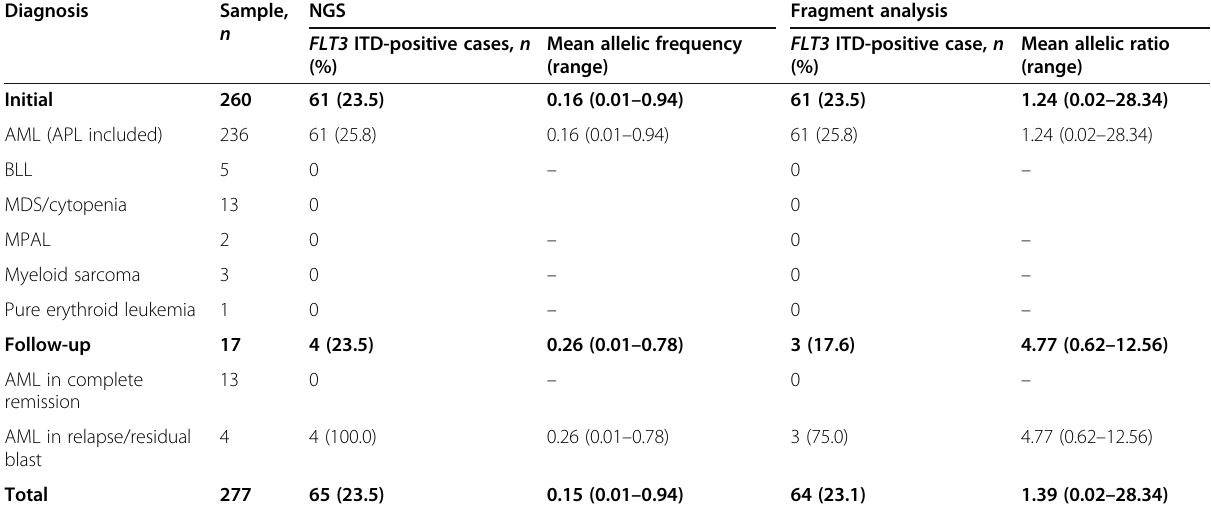
Table 1 Summary of diagnosis and FLT3 ITD results from patients